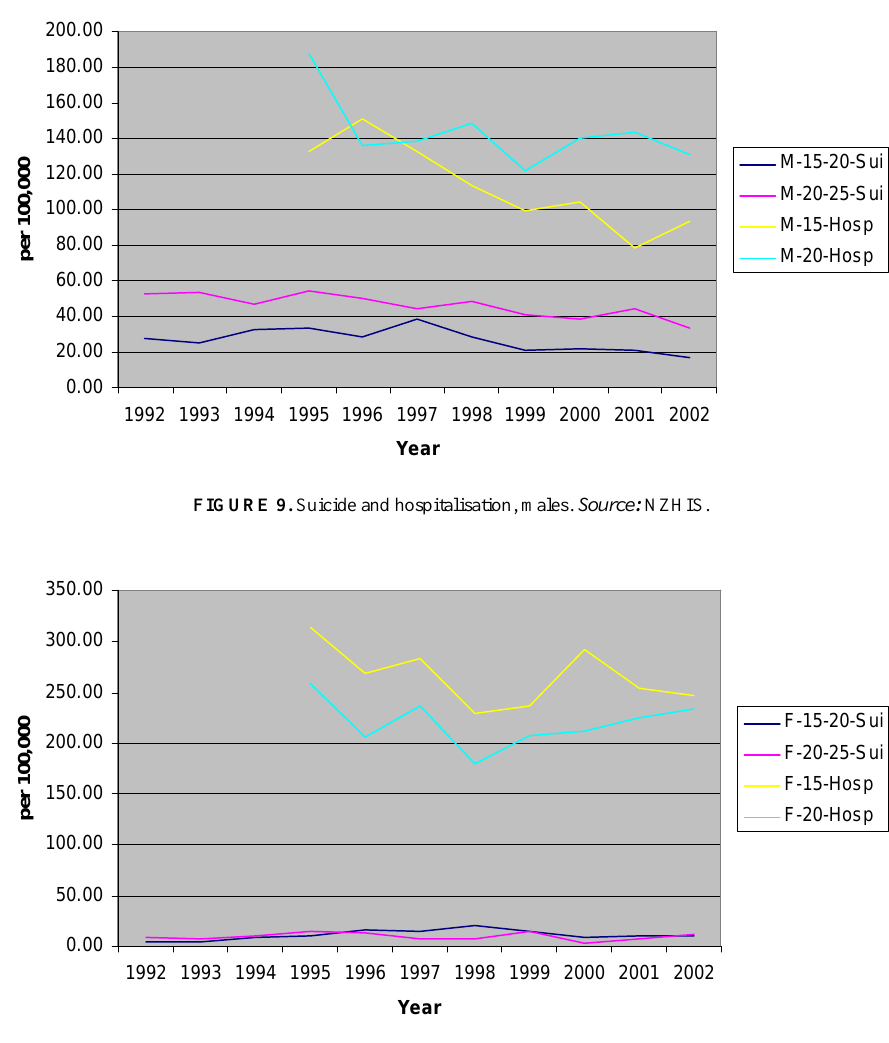
FIGURE 10. Suicide and hospitalisation, females. Source: